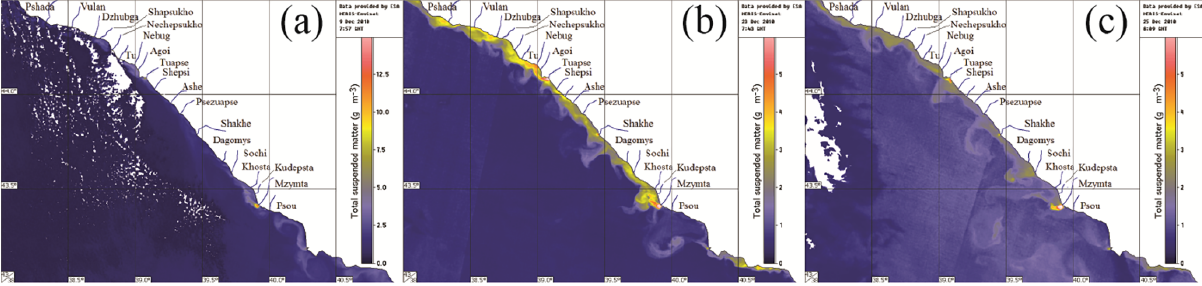
trial period and for 6–8 out of 14 days of the second trial